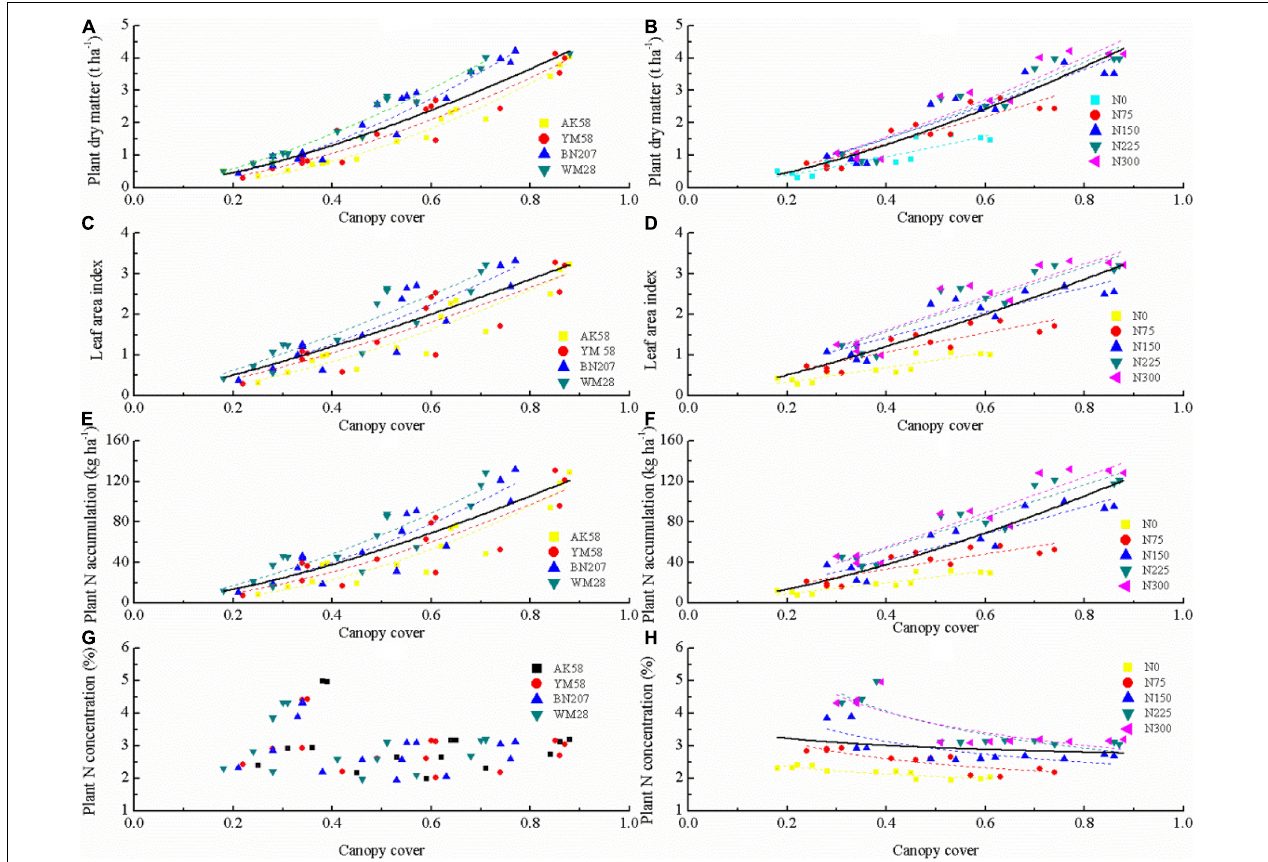
FIGURE 2 | Comparison of the regression relationships of canopy cover (CC) with shoot dry matter (SDM), leaf area index (LAI), shoot nitrogen accumulation (SNA), and shoot nitrogen concentration (SNC) among cultivars and nitrogen(N) fertilization levels. Curves are fitted lines to an allometric function ( Y = aX b ). (A) , (C) , (E) , and (G) denote the relationships between CC and SDM, LAI, SNA and SNC across different cultivars, respectively. (B) , (D) , (F) , and (H) denote the relationships between CC and SDM, LAI, SNA and SNC across different N treatments,